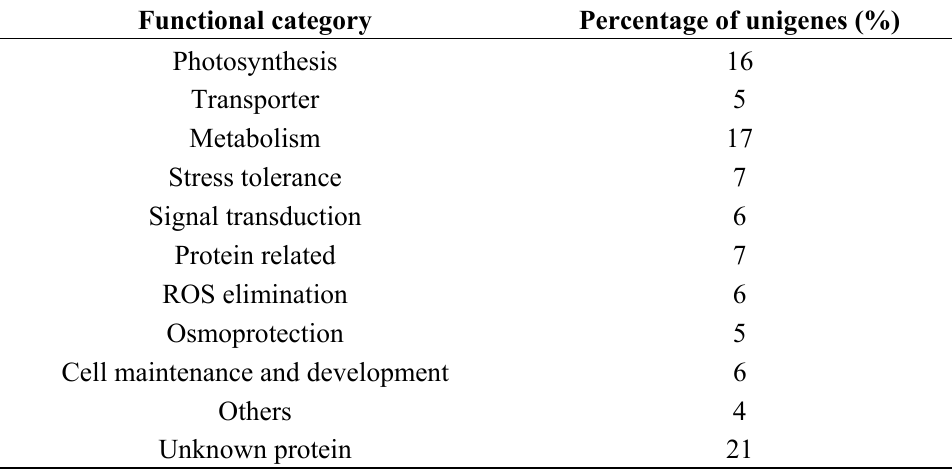
Table 1. The functional categorization of the putative salt-responsive